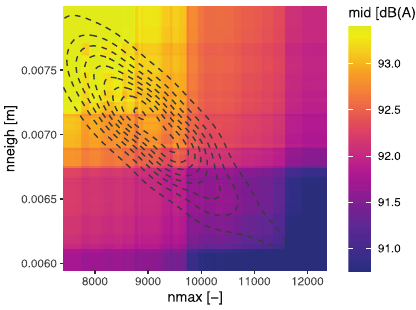
Figure 13. Visualization of the mid frequency random forest predictions; the estimated CPX levels are color-coded, the dashed contour lines denote the kernel density estimates of the input data, thus marking the areas of model inter- and extrapolation.